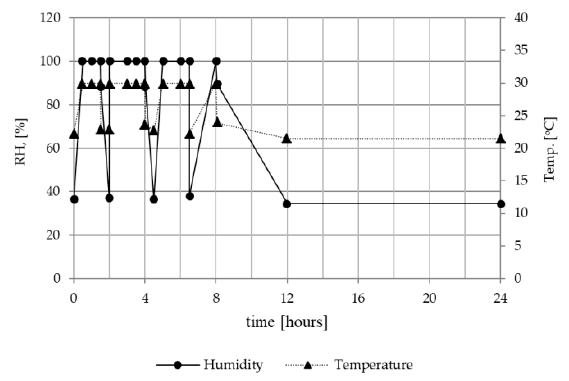
Figure 1. Daily changes of temperature and air humidity used for conditioning of filtering